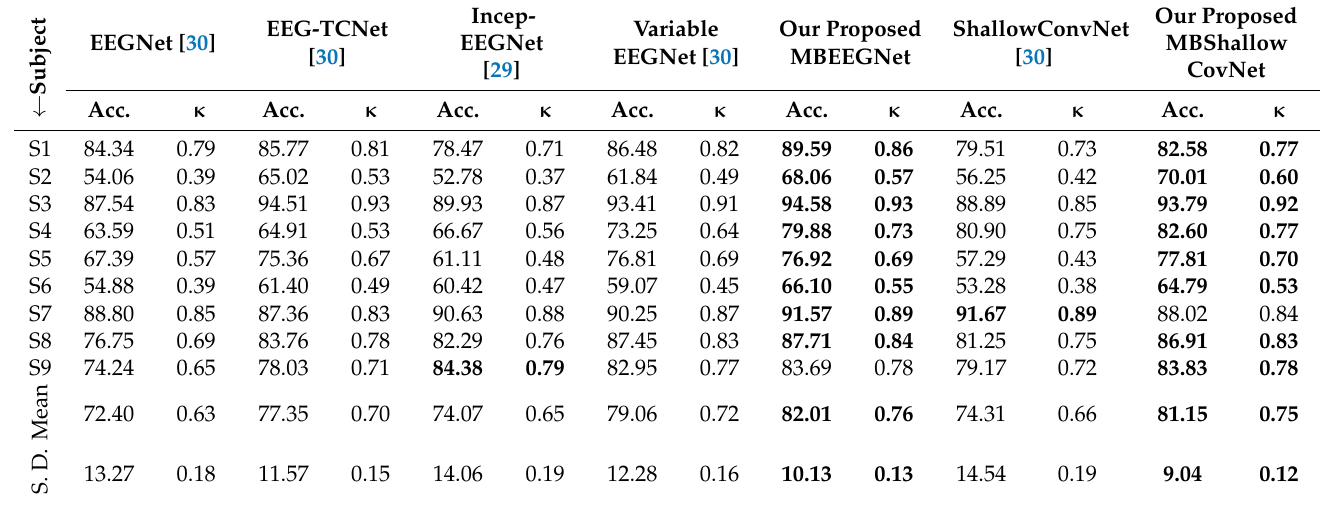
Table 3. Classification accuracy (%) and κ -scores on the MI BCI IV-2a